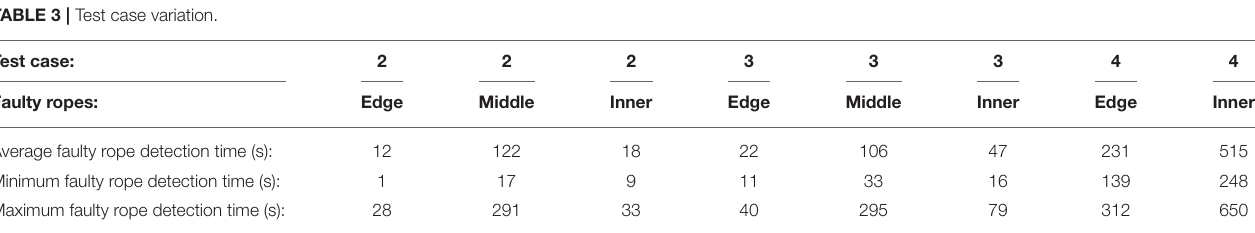
TABLE 3 | Test case